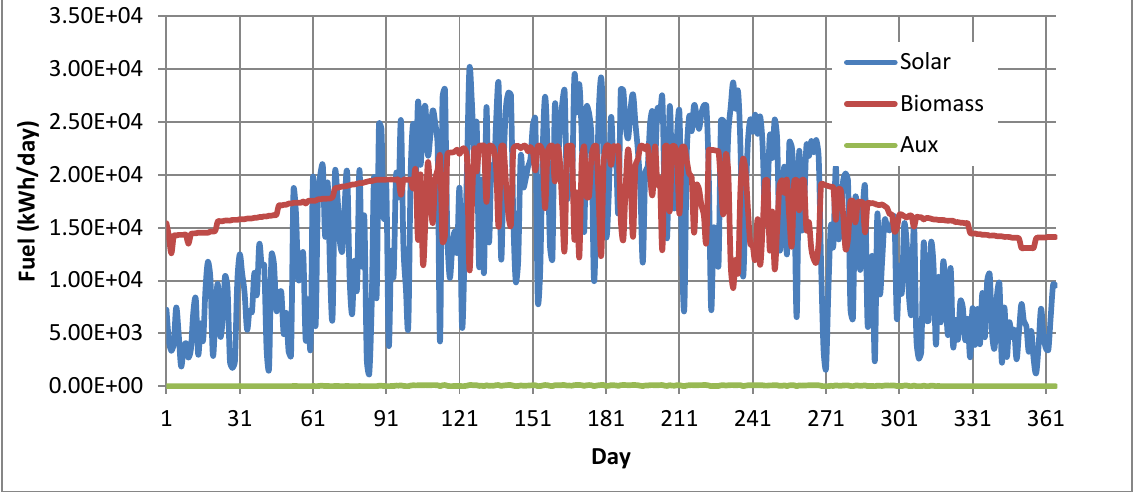
Figure 3. Daily exergy